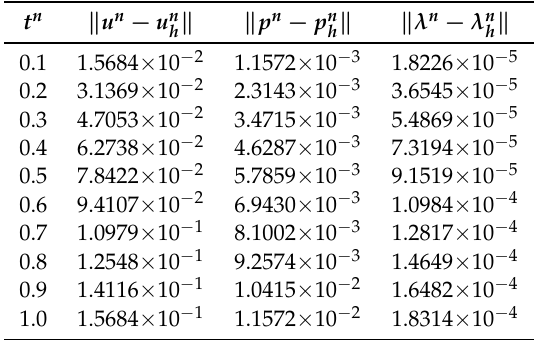
Table 5. Discrete errors with time steps for Example 2, nb = 2, h = 1/64, δ t =